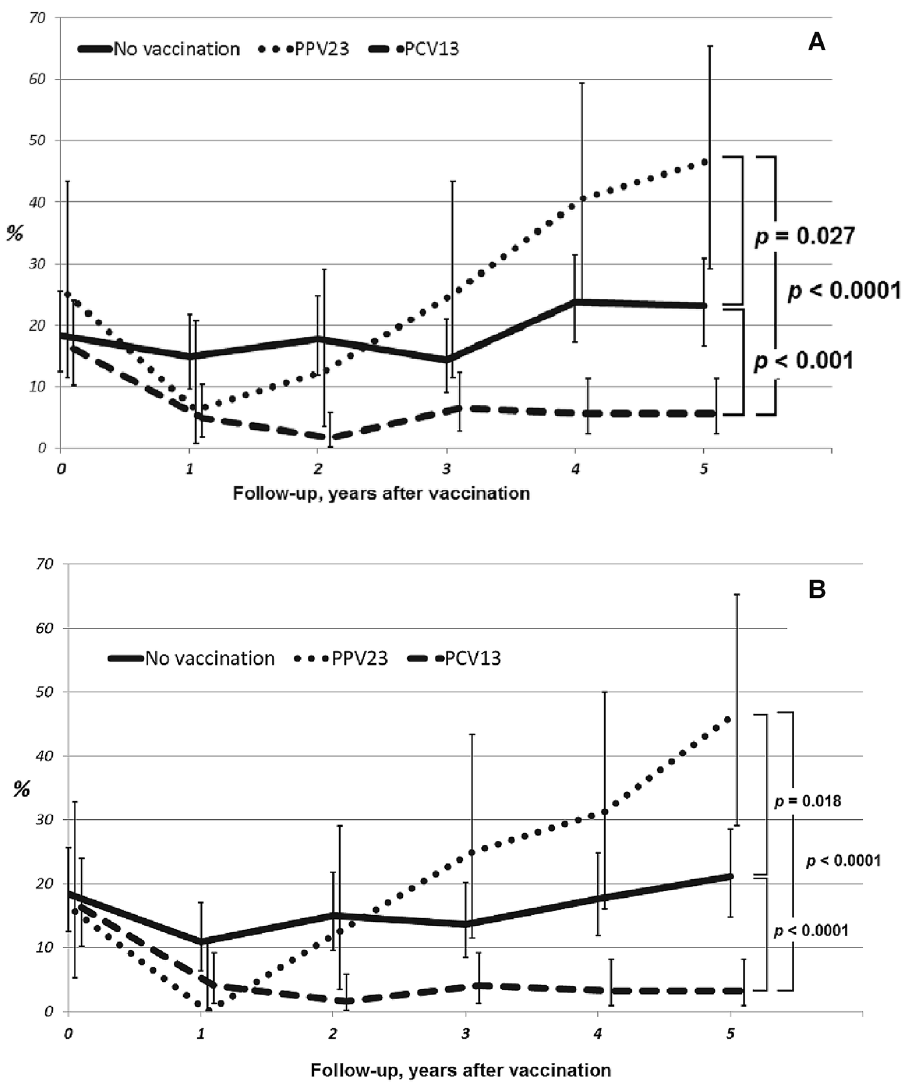
Figure 1. Dynamics of total pneumonia rate ( A ) and rate of hospitalizations with pneumonia ( B ) in the study groups. p value showed ANOVA statistics between groups. The p value shows ANOVA statistics between